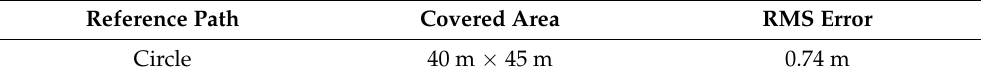
Table 8. The indoor positioning of the proposed H 2 estimation design in the practical